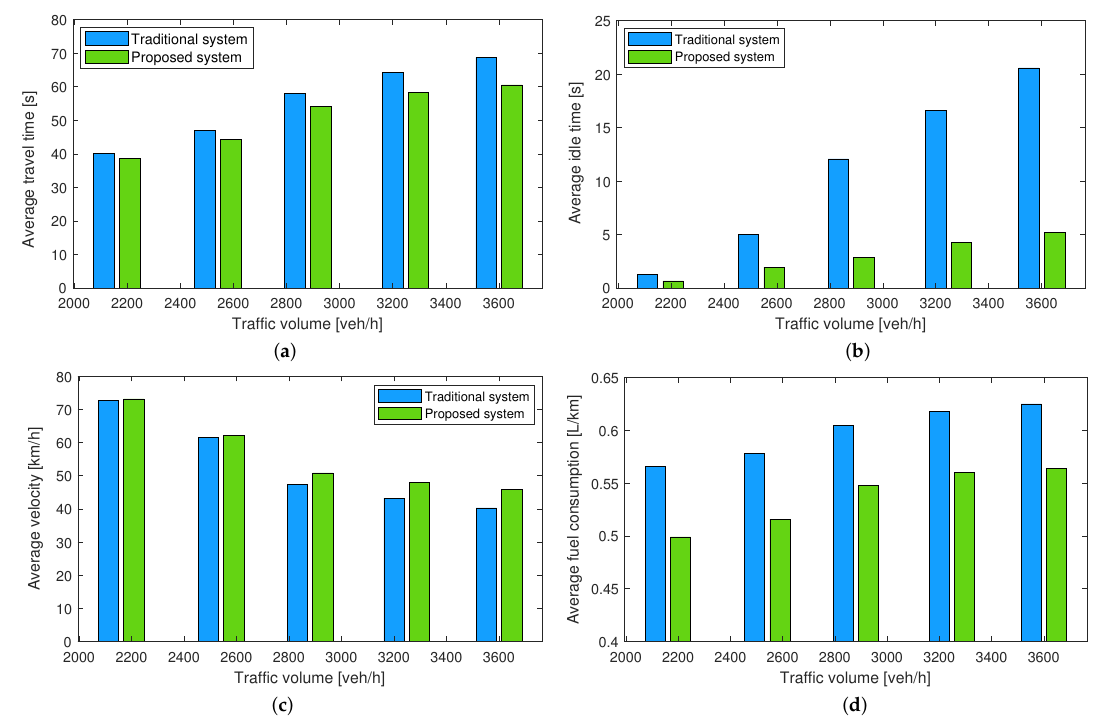
Figure 8. Performance comparison ( a ) average travel time, ( b ) average idling time, ( c ) average velocity, and ( d ) average fuel consumption of the traditional driving system and the proposed traffic coordination system for various traffic volumes on the model